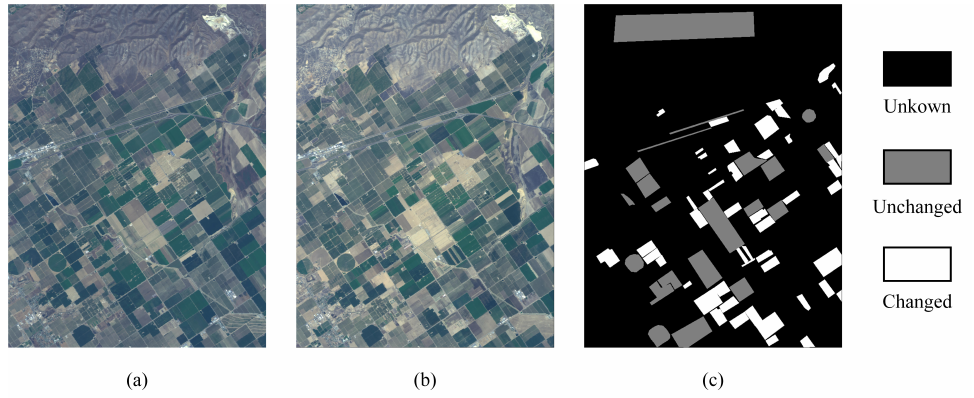
Figure 4. The Santa Barbara dataset. ( a ) Image acquired in 2013. ( b ) Image acquired in 2014. ( c ) Reference